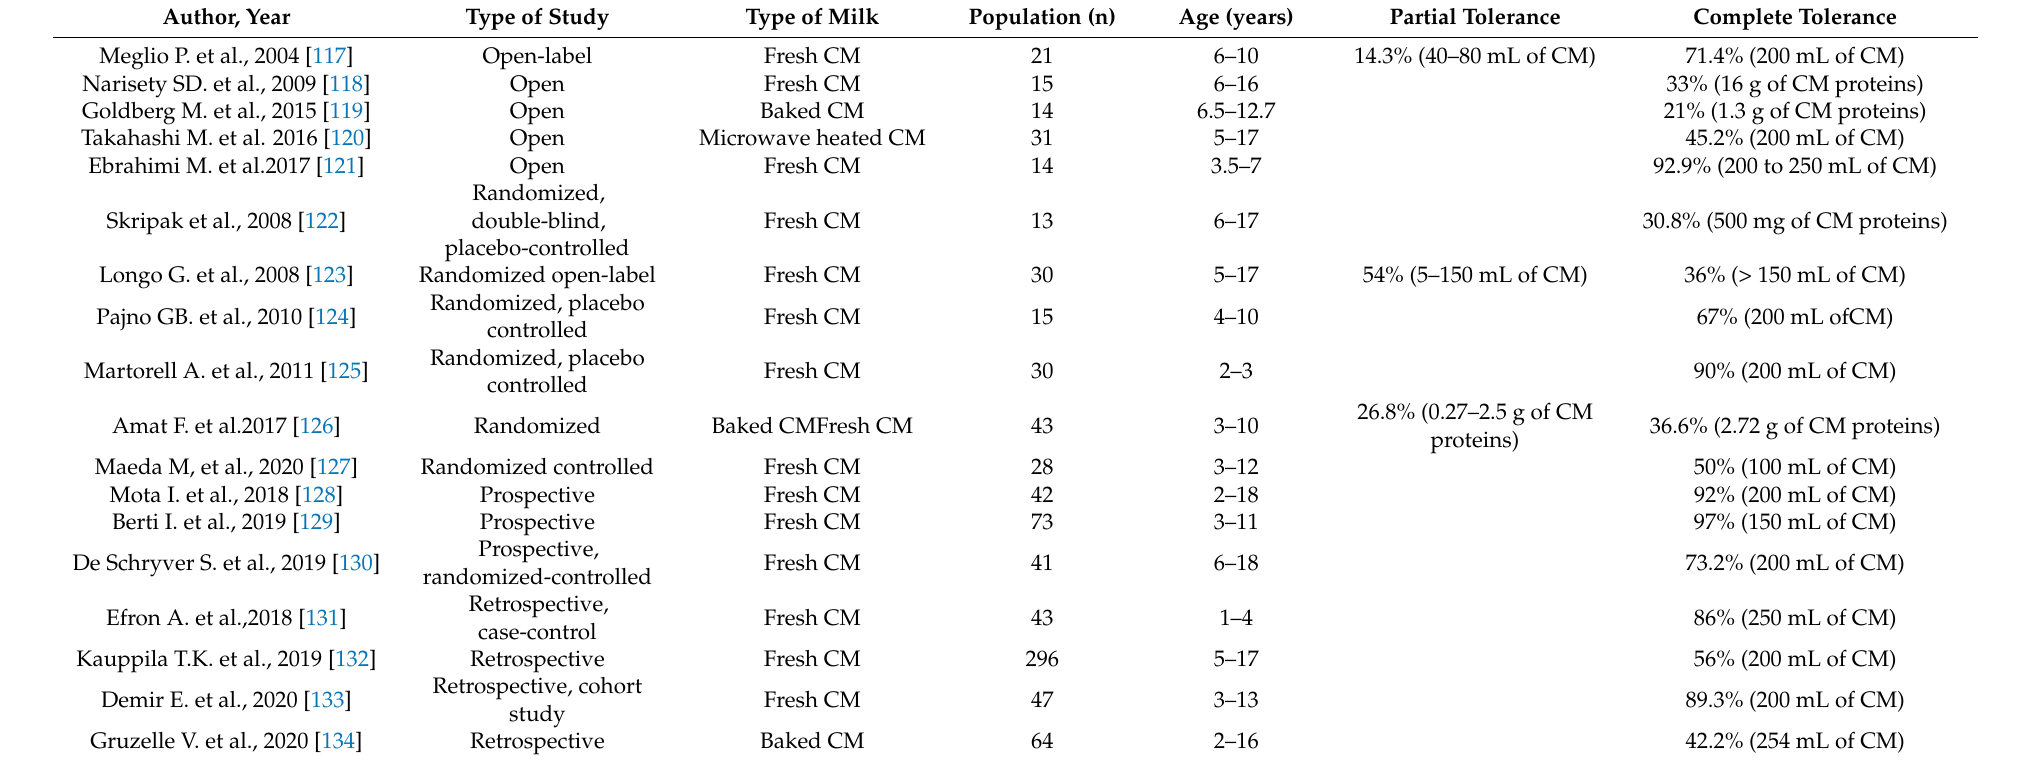
Table 5. Efficacy of milk